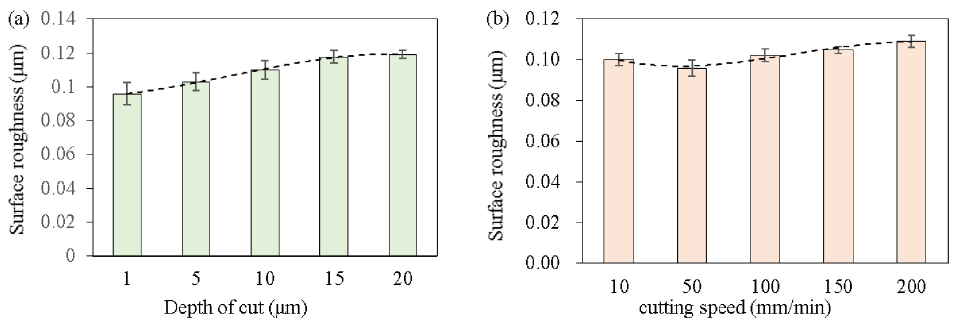
Figure 8. Roughness results of the micro-groove machined surface; ( a ) the cutting speed was 60 mm/s, ( b ) the depth of cut was 8 µ